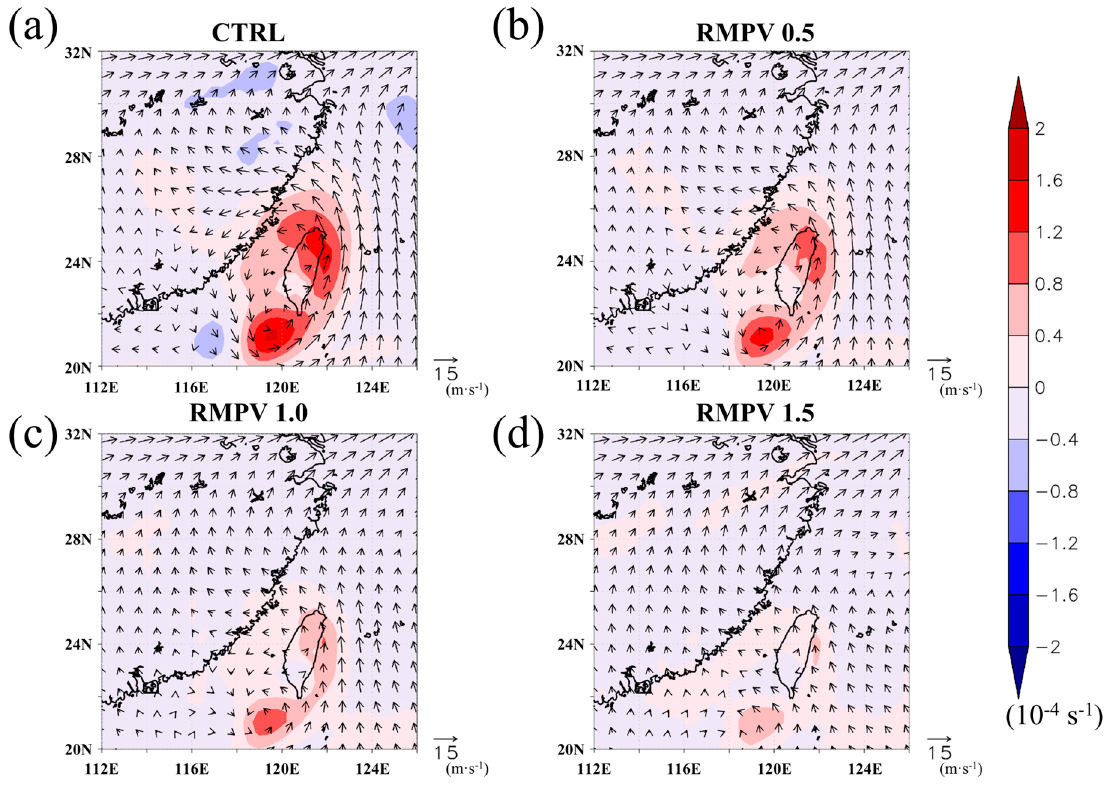
Figure 8. Initial fi eld of 500 hPa vorticity (shading; 10 − 4 s − 1 ) and wind vectors (arrows; m s − 1 ) at 0600 UTC 29 August ( − 42 h) in ( a ) CTRL, ( b ) RMPV0.5, ( c ) RMPV1.0 and ( d ) RMPV1.5.